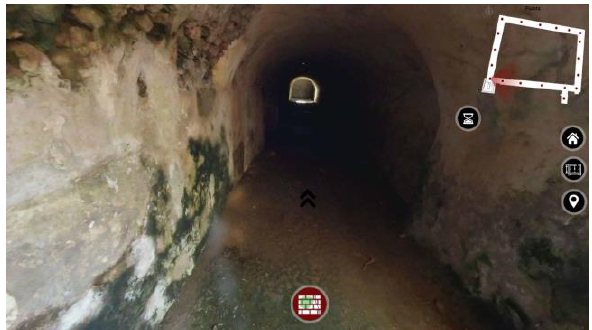
Figure 9. Spherical visualization of the n3 equirectangular image in the VT_RGB